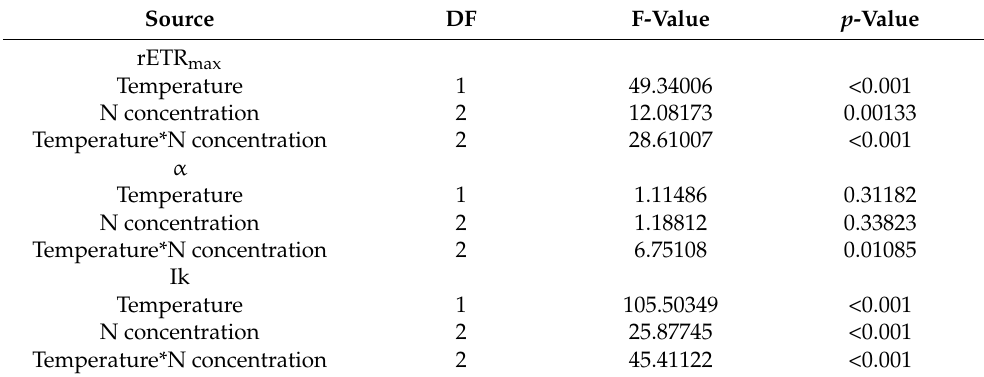
Table 4. Results of two-way ANOVA for photosynthetic parameters derived from the rapid light curves (RLCs) of PSII of S. horneri under LN, IN, and HN, treated by CT and ET.